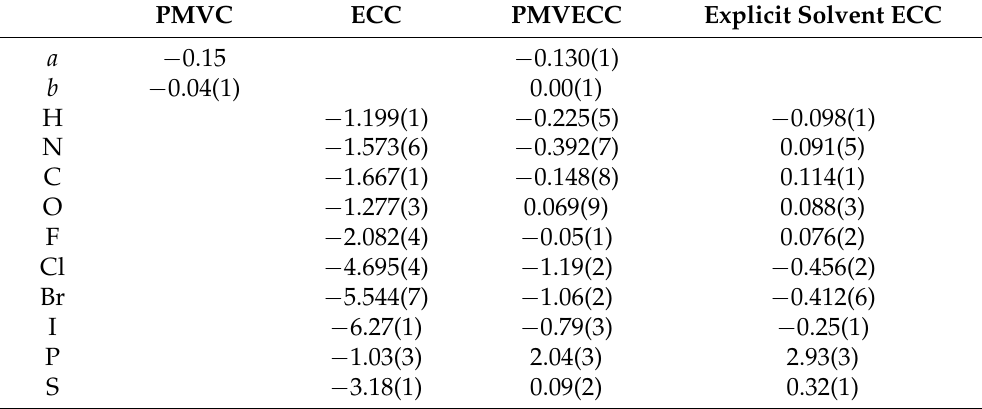
Table 1. Fit parameters for PMVC, ECC, and PMVECC, averaged over all leave-one-out fits. Un- certainties in the last digit are given in parentheses, and represent the standard deviation over all leave-one-out fits. Uncertainty for the a coefficient for PMVC is 8 × 10 − 5 kcal/mol/ ˚A 3 . Coefficient a is in kcal/mol/Å 3 . All other values are in kcal/mol. See Section 5.5 for details of the fitting procedure.